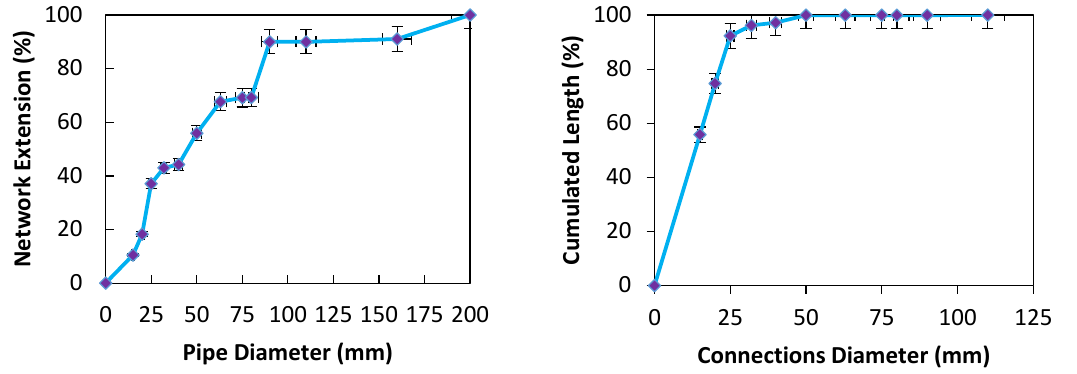
Figure 5. Pipelines by diameter: along the WDN extension ( left ) and connections by cumulated length ( right ).